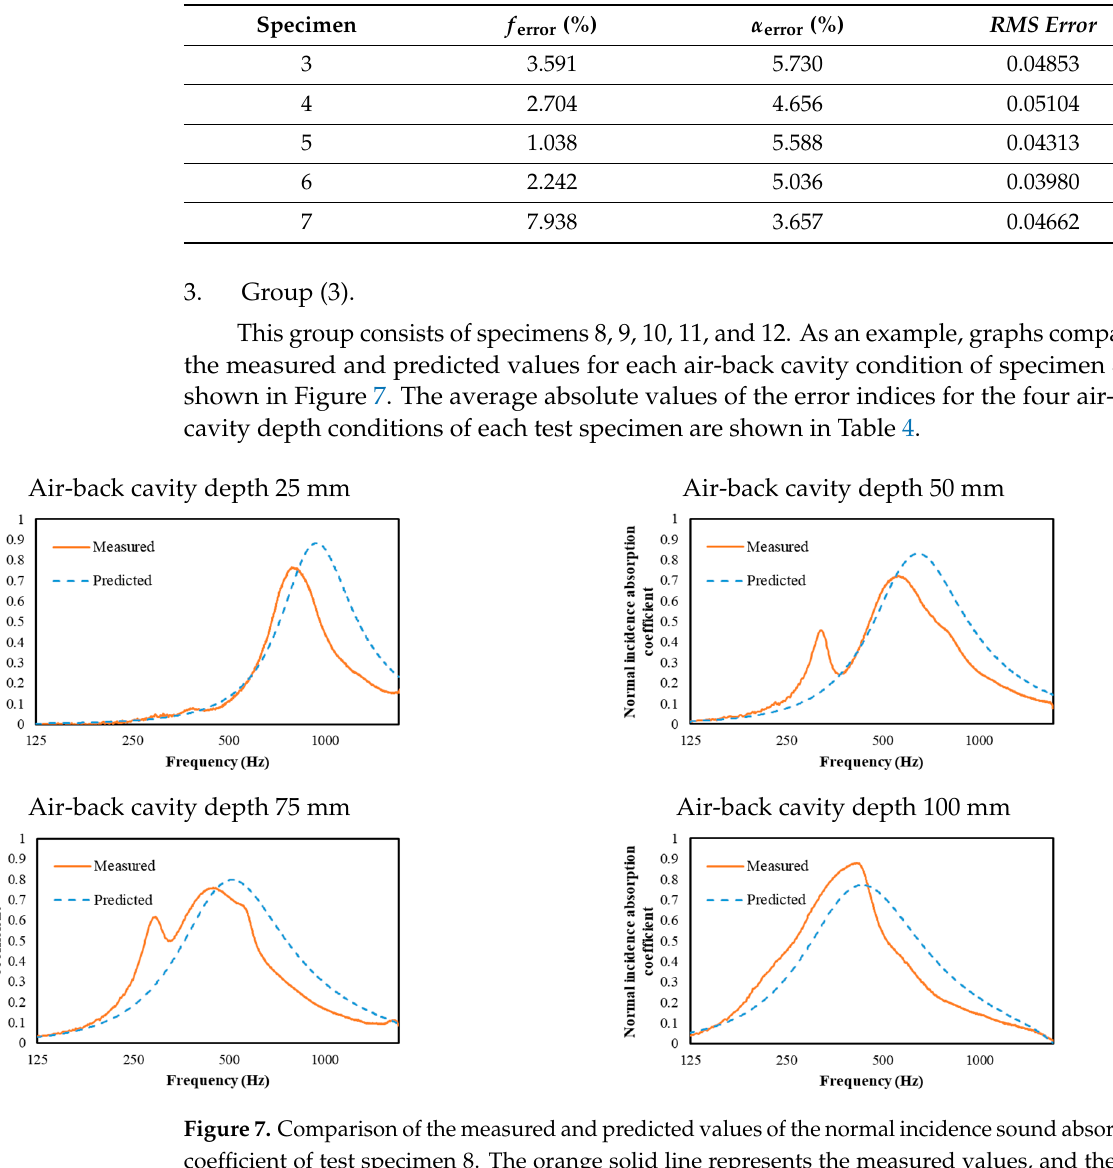
Table 3. Mean values of the error indices for the four conditions of air-back cavity depth of specimens 3, 4, 5, 6, and 7.